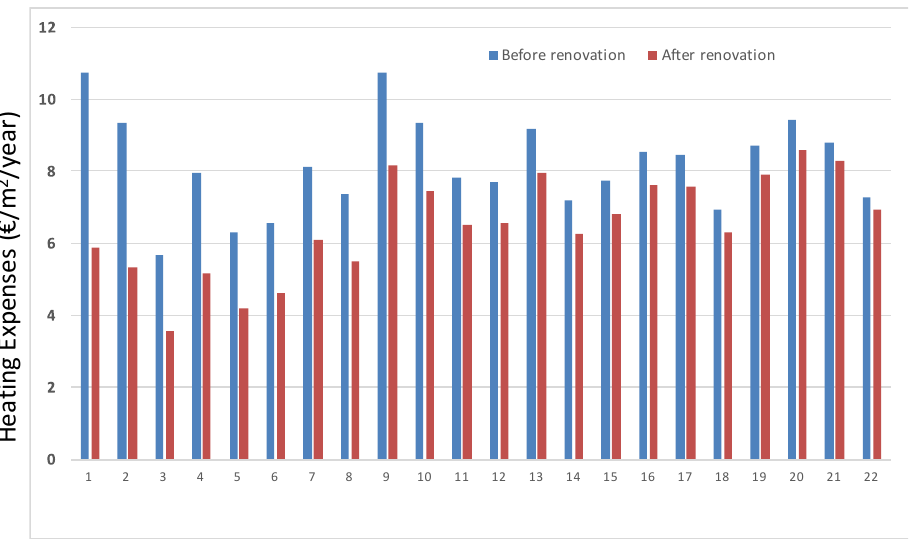
Figure 3. Impact of renovation of Category E buildings on the heating expenses.